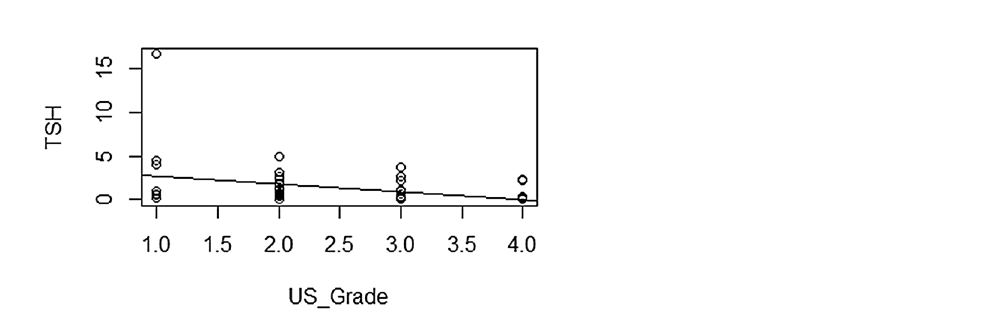
Figure 7. Graphic presentation of linear negative correlation of the TSH level and the severity of US grades in hyperthyroidism. (R software, ver. 4.0.4; R Foundation for Statistical Computing, Vienna, Austria).